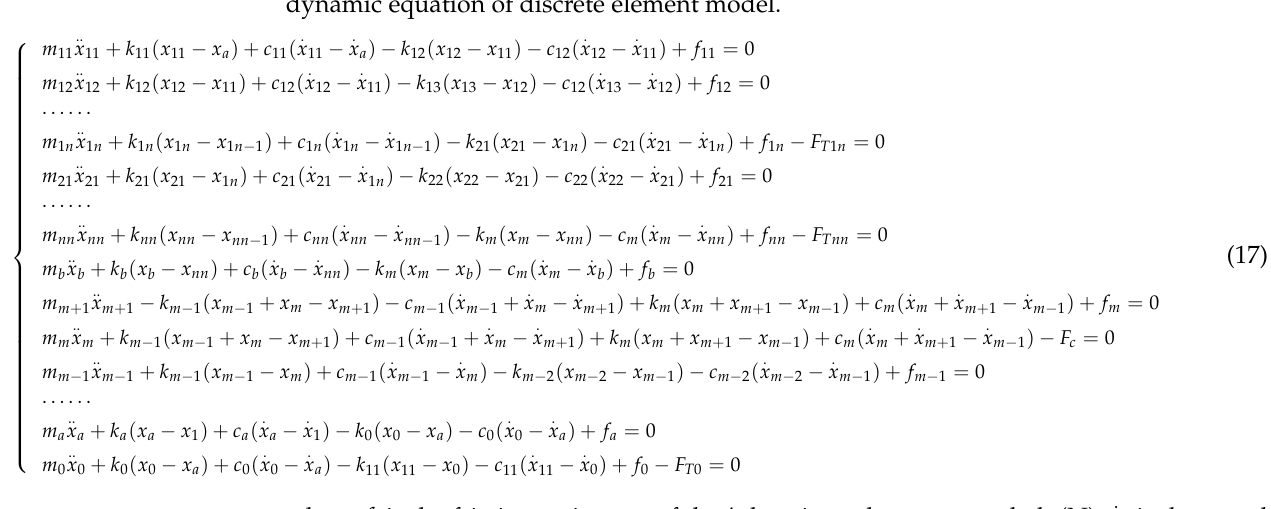
Figure 5. Logic block diagram of multi-motor ring coupling control strategy.